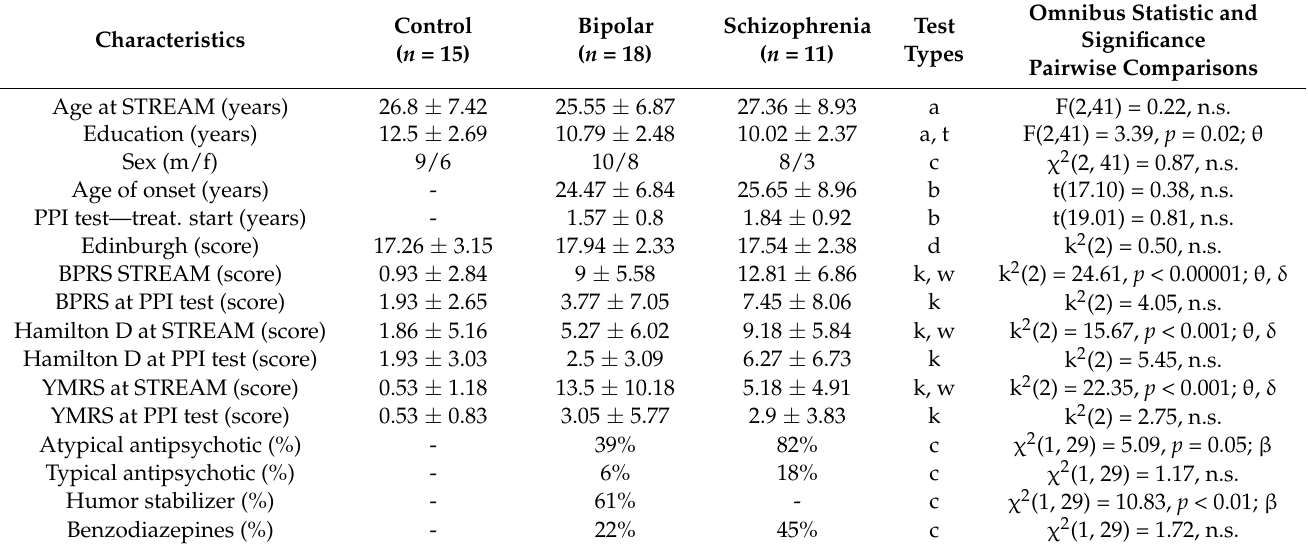
Table 1. Socio-demographic and clinical characteristics of the sample.